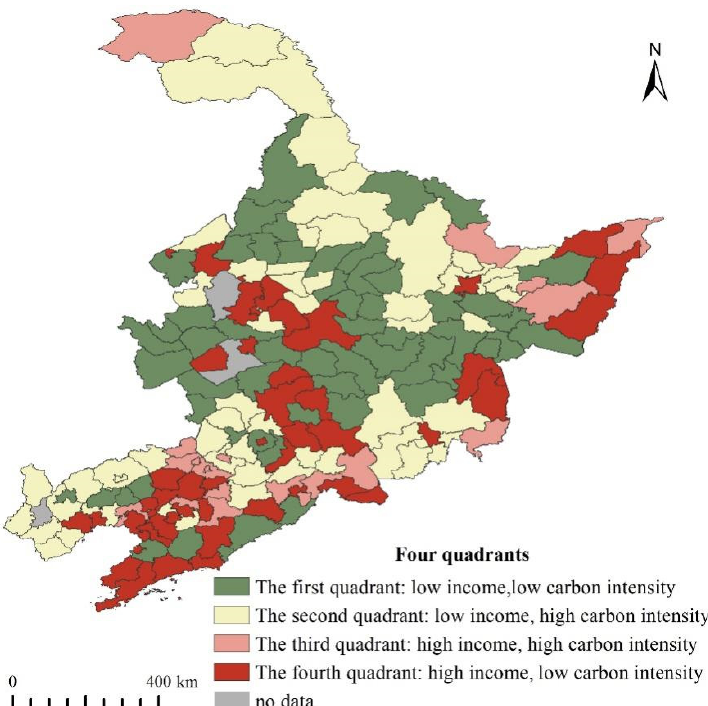
Figure 8. Four quadrants of GDP per capita and carbon intensity in Northeast China.